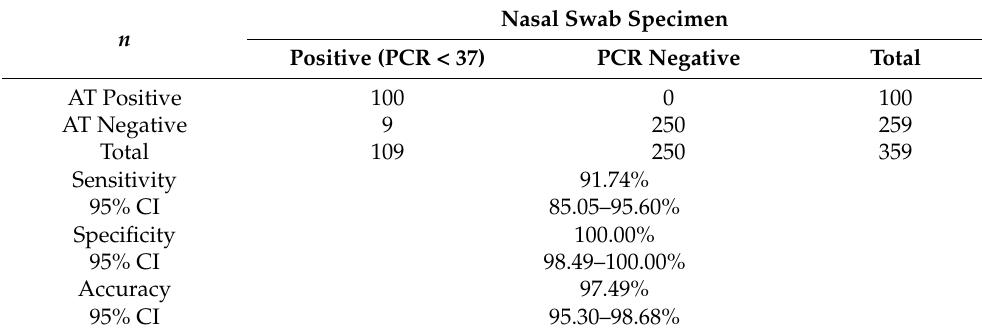
Table 6. Test results and analysis of nasal swab specimens with Ct values of PCR positivity less than